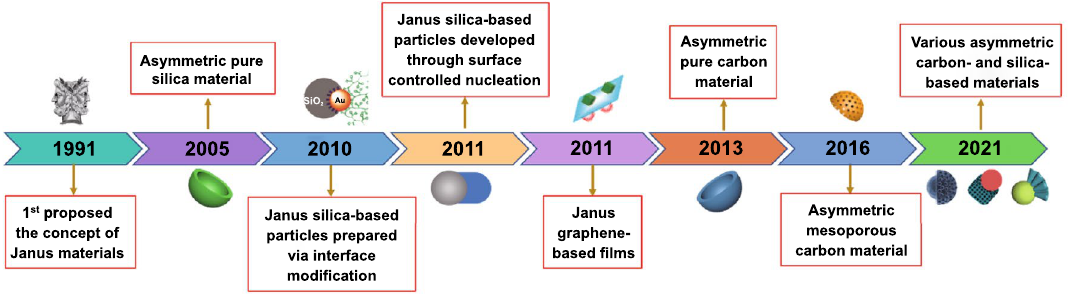
Fig. 1 Historical development of asymmetric carbon- and silica-based